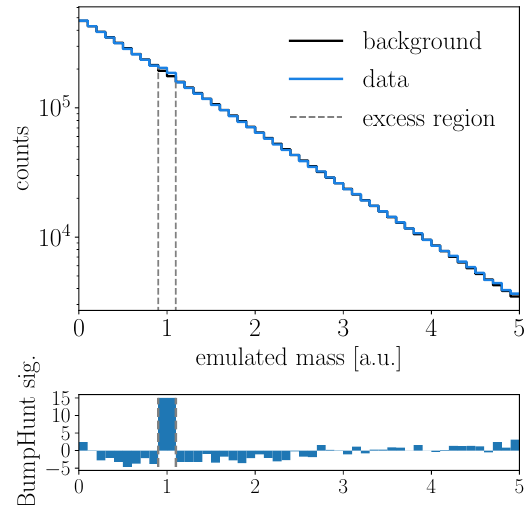
Figure 5: Example of the B UMP H UNTER used on the training data, based on the background model of Eq.(2). Dotted lines indicate the upper and lower bounds of the signal region. The lower panel shows the